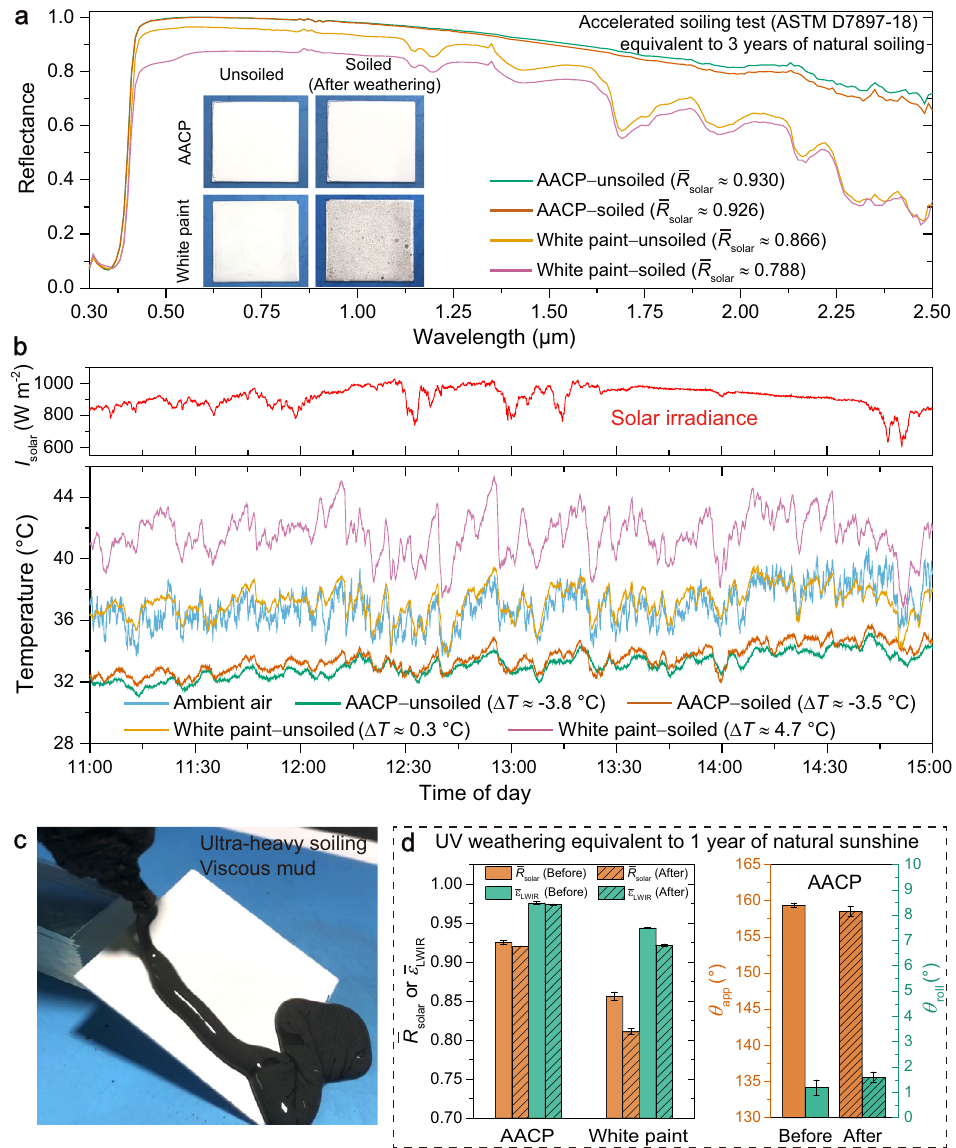
Fig. 3 | Anti-aging performances of AACP against heavy soiling and long-term UV exposure. a R ̅ solar after accelerated soiling test based on ASTM D7897-18 standard, equivalent to 3years of natural soiling. The soiled AACP coating demonstrated almost intact R ̅ solar compared with the unsoiled one. Insets present visualappearancesofthecoatingsamplesbeforeandaftersoiling. b Measurements